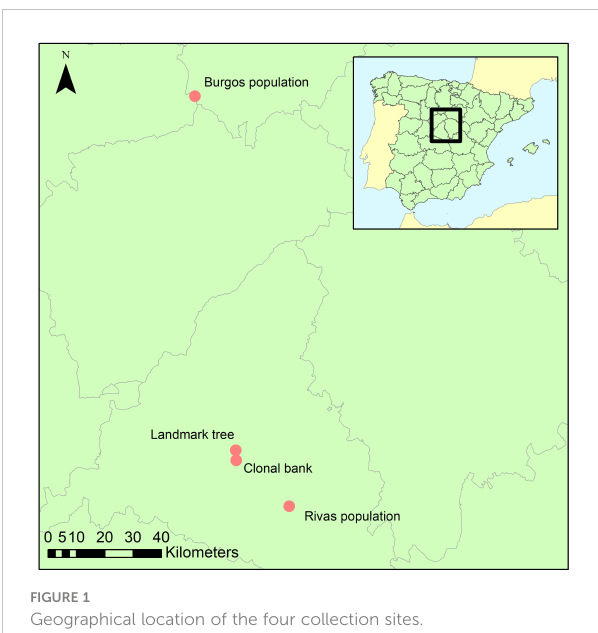
FIGURE 1 Geographical location of the four collection